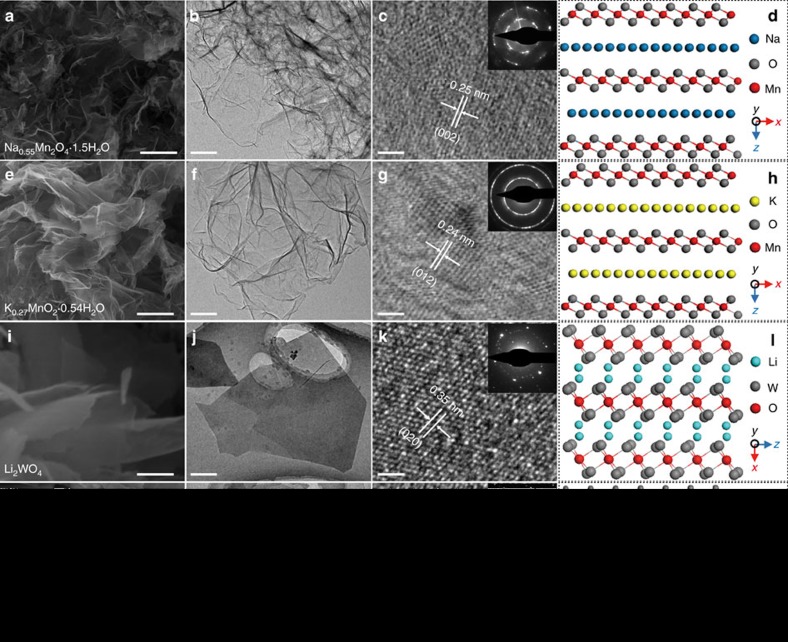
Characterization of cation intercalated 2D oxides.Characterization of Na0.55Mn2O4·1.5H2O. (a) SEM image; (b) low-resolution TEM image; (c) high-resolution TEM image; (d) atomic structure. Characterization of K0.27MnO2·0.54H2O. (e) SEM image; (f) low-resolution TEM image; (g) high-resolution TEM image; (h) atomic structure. Characterization of Li2WO4. (i) SEM image; (j) low-resolution TEM image; (k) high-resolution TEM image; (l) atomic structure. (d) Characterization of Na2W4O13. (m) SEM image; (n) low-resolution TEM image; (o) high-resolution TEM image; (p) atomic structure. Scale bar for a,e,i,m is 1 μm, b,f,j,n is 200 nm and c,g,k,o is 2 nm.